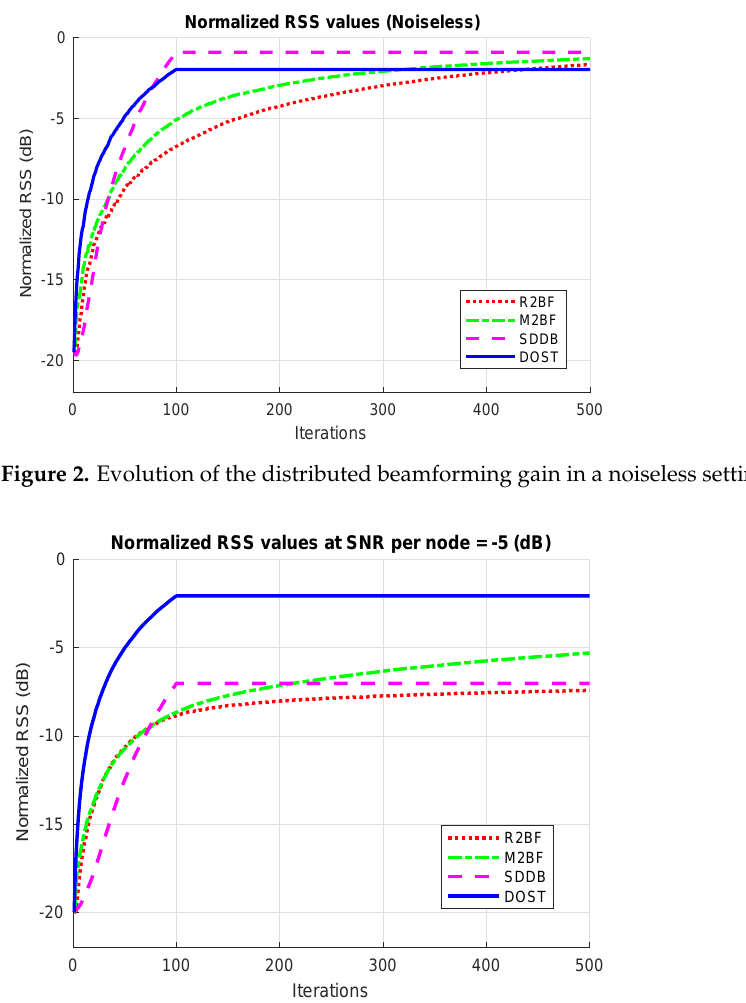
Figure 3. Evolution of the distributed beamforming gain for N = 100 nodes at SNR per node − 5